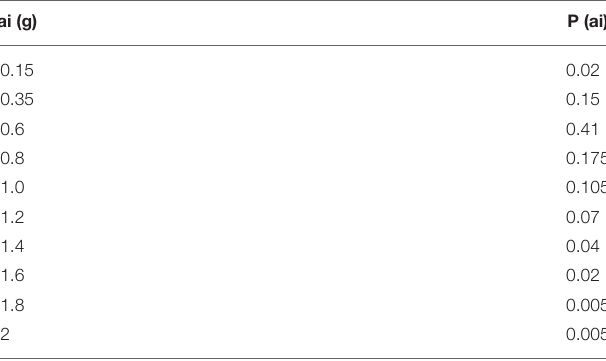
TABLE 6 | Scenario seismic ground accelerations and occurrence probabilities for Oaxaca.